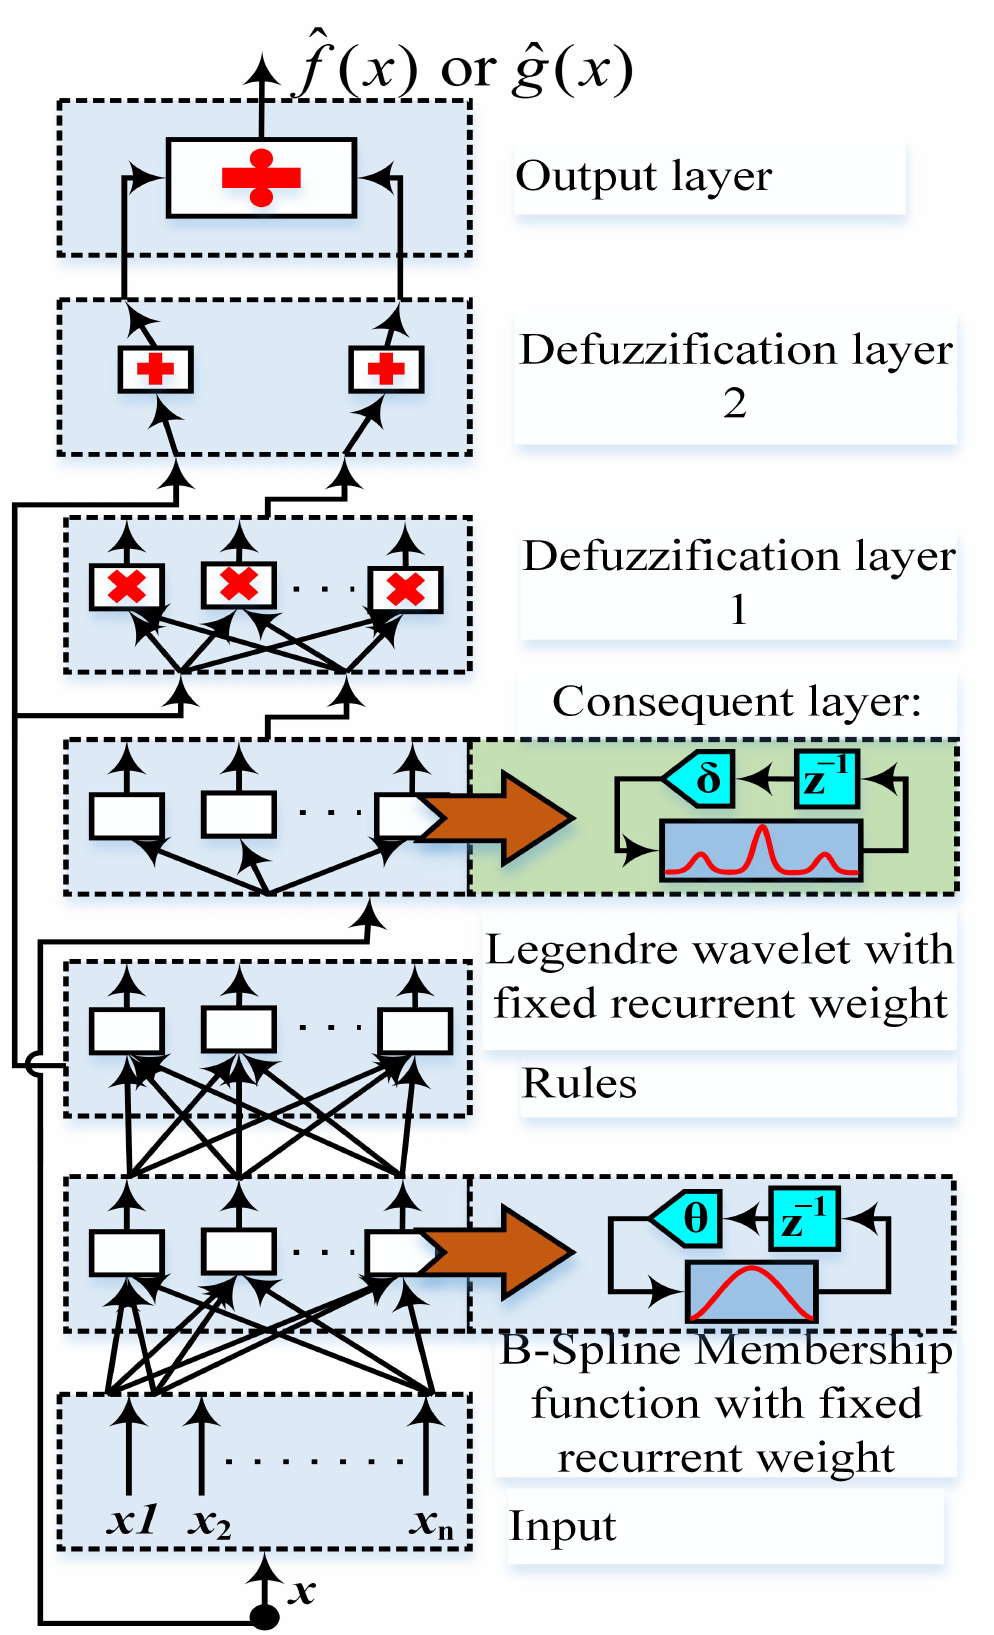
Figure 7. B-Spline membership function and Legendre